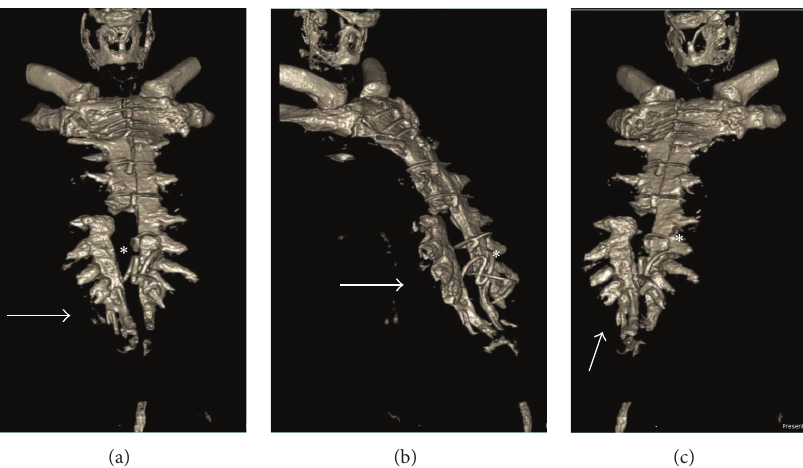
Figure 1: Preoperative 3-dimensional computed tomography showing the right lower part of the “floating” sternum. (a) Anterior-posterior view, (b) right anterior-oblique view, and (c) left anterior-oblique view showing the dehisced right lower part of sternum (highlighted with an arrow ) with sternal wires that have pulled through (highlighted with an asterisk ).